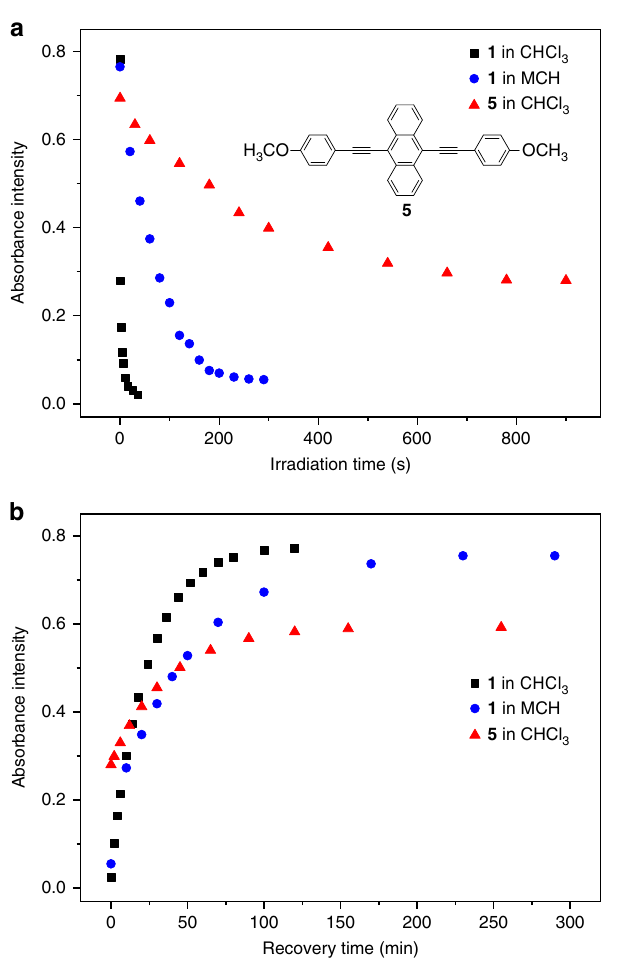
Fig. 6 Anthracene ‒ endoperoxide photo-switching kinetics. a Photo- oxygenation and b deoxygenation kinetics of 1 in CHCl 3 (black square), in MCH (blue circle), and 5 in CHCl 3 (red triangle) on the basis of UV – Vis measurements. For 1 and 5 (2.00 × 10 − 4 M, 293 K), the absorbance signals are monitored at 484 nm, and 470 nm, respectively inkjet-printed QR pattern can be read and hidden for multiple cycles (Fig. 8b).